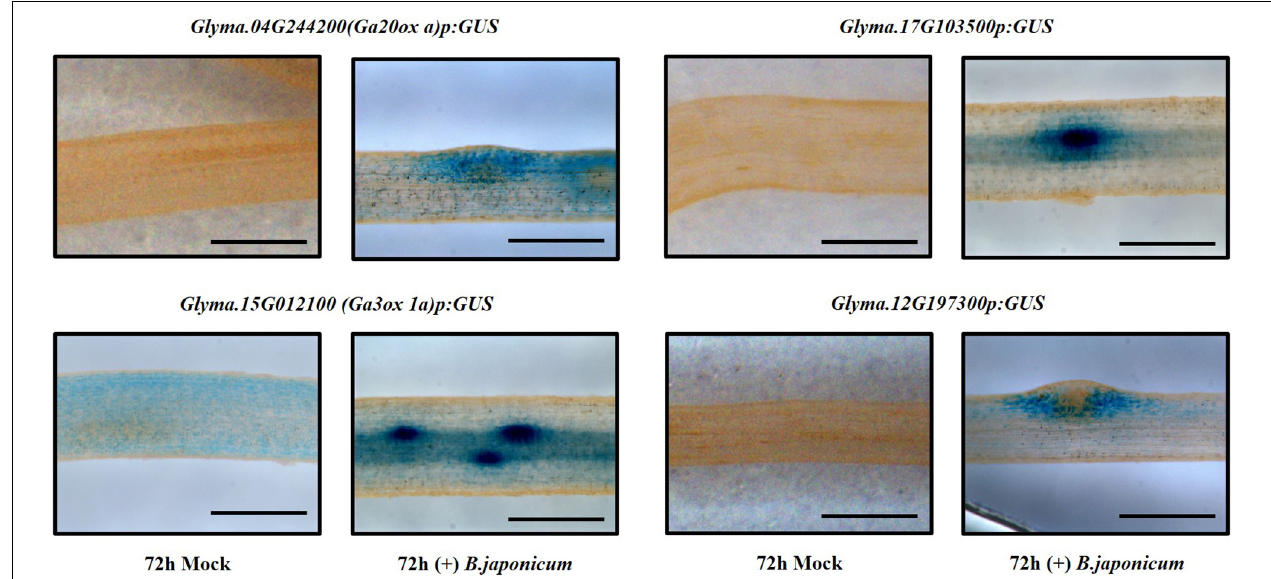
FIGURE 3 | Promoter-GUS expression analysis of candidate genes, Glyma.04G244200 , Glyma.15G012100 , Glyma.17G103500, and Glyma.12G197300 in soybean roots 72 h after inoculation with B. japonicum (scale bar = 500 µ